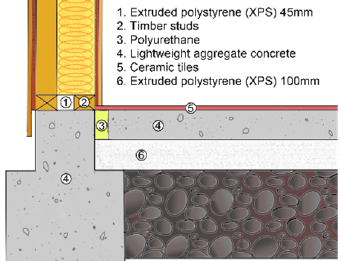
Figure 5. Details of the wall–floor junction, view in section. Own elaboration.